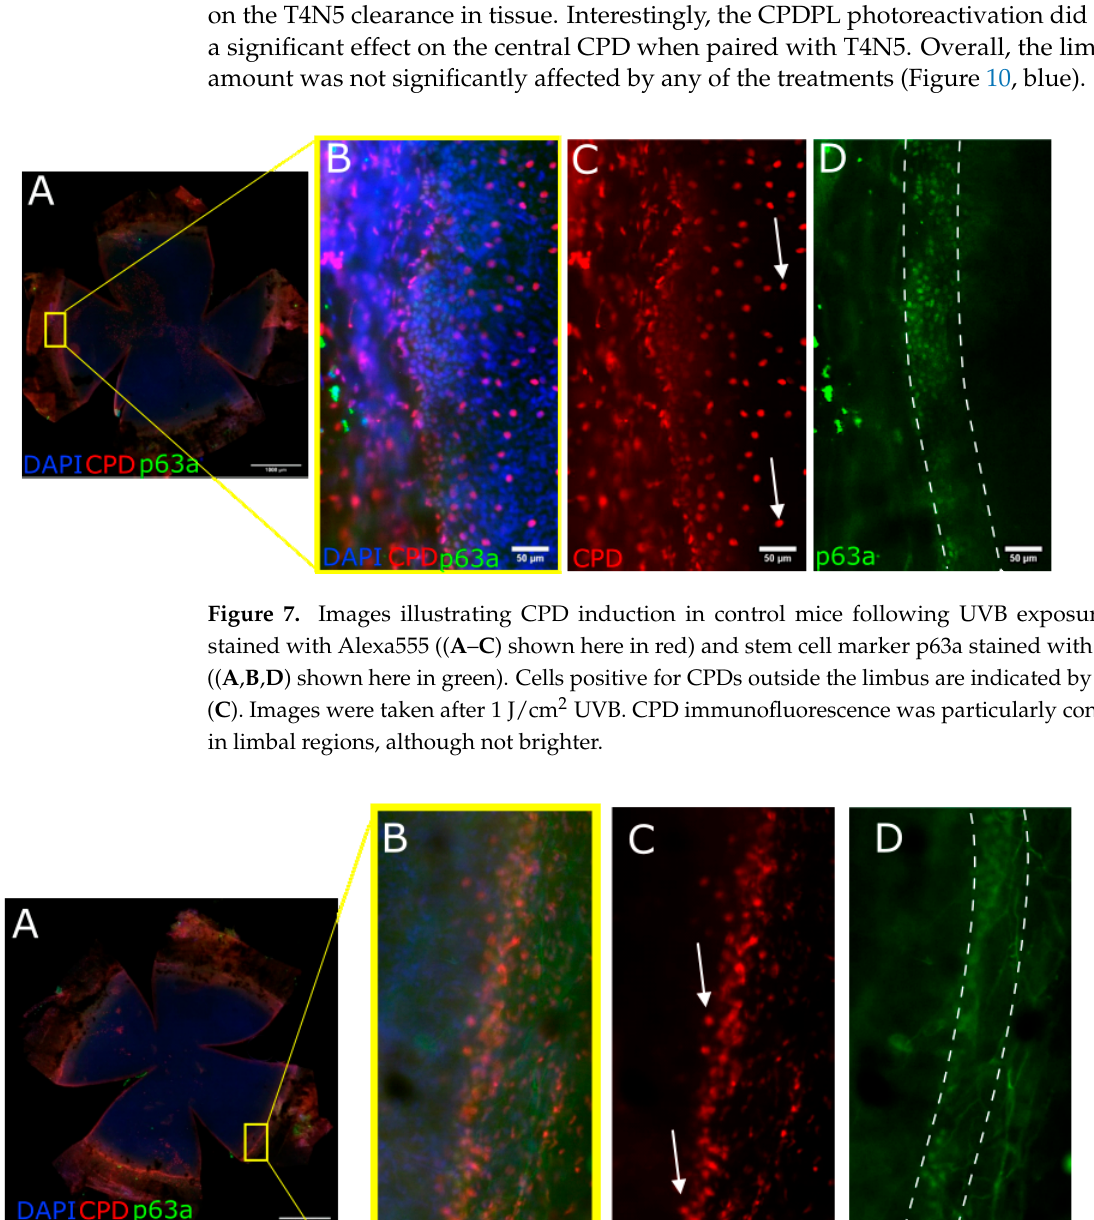
Figure 9. Images illustrating recovery of induced CPDs in control mice and CPDPL mutant mice following UVB exposure and either photoreactivation and 48 h with vehicle control ( A ) and T4N5 ( B ), or T4N5 and 30 min photoreactivation ( C ). CPDs stained red. Images were taken after 1 J/cm 2 UVB and 48 h of incubation. CPD immunofluorescence was highest in irradiated tissue treated with vehicle control.